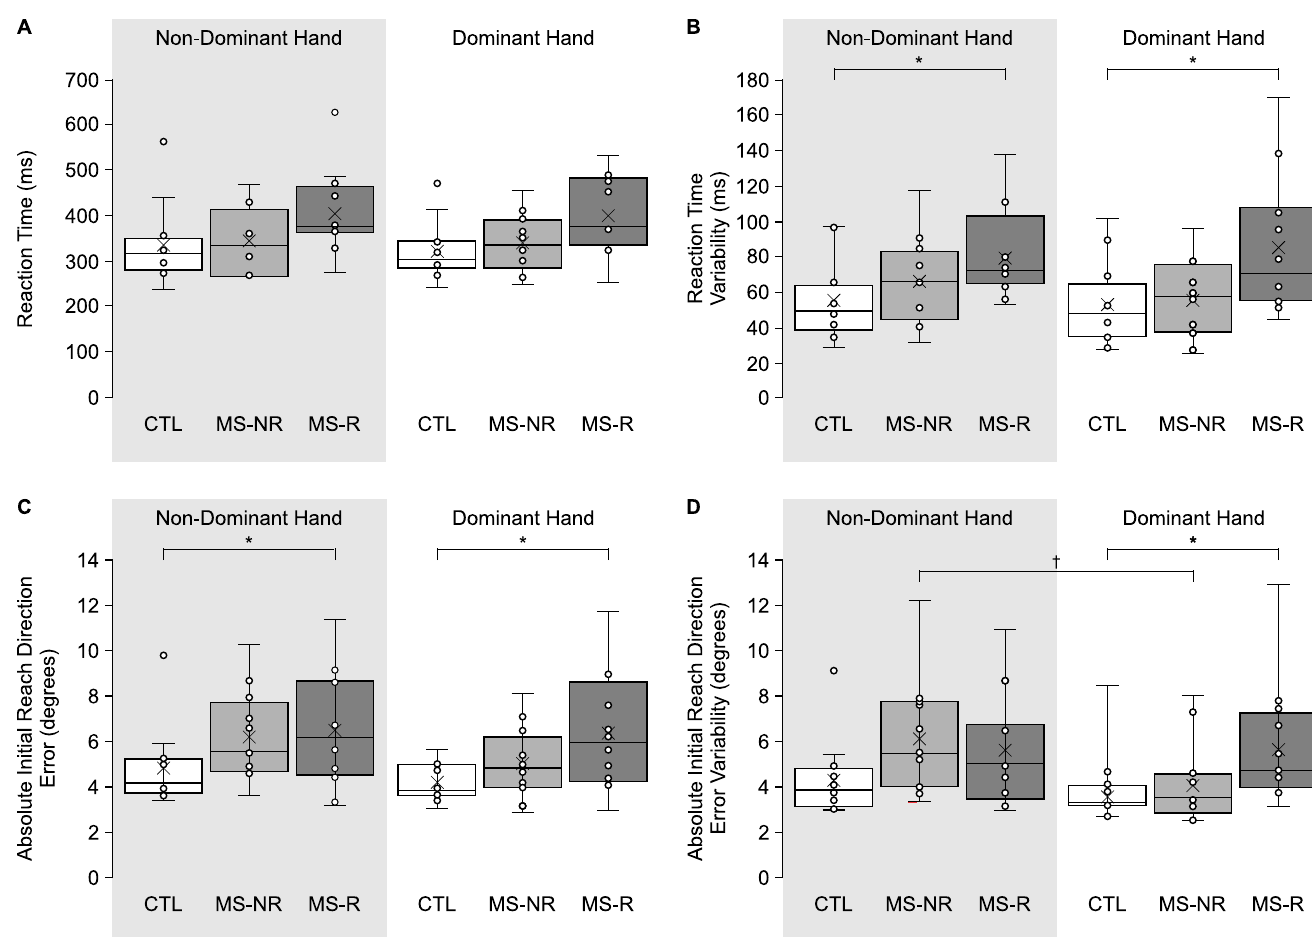
Fig 3. Box-and-whisker plots of offline movement planning measures. (A-B) Mean and variability of reaction time (ms). (C-D) Mean and variability of absolute initial reach direction error (degrees). Shaded area represents reaches performed with the non-dominant hand. White bars represent reaching performance by control participants (CTL), light grey bars represent reaching performance by PwMS who reported no upper limb impairment (MS-NR) and dark grey bars represent reaching performance by PwMS who reported upper limb impairment (MS-R). Error bars represent standard error of mean. Asterisks ( � ) represent significant differences between MS-R and CTL ( p < 0.05). Dagger (†) represent a significant difference between Hands ( p < 0.05).